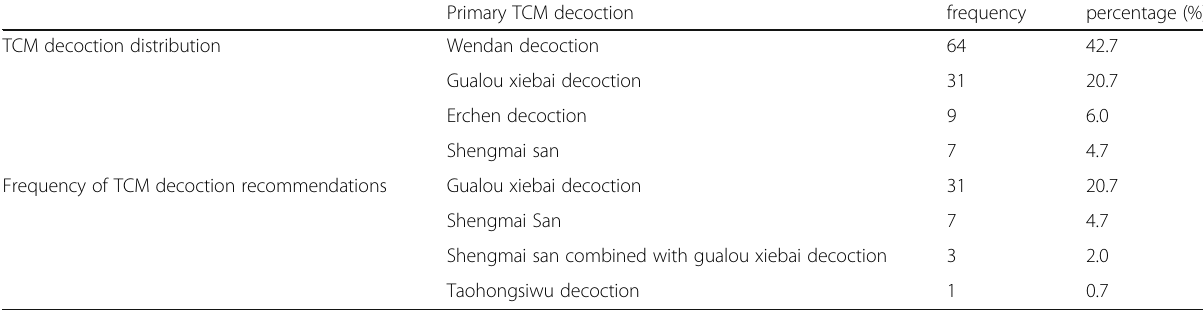
Table 8 TCM decoction